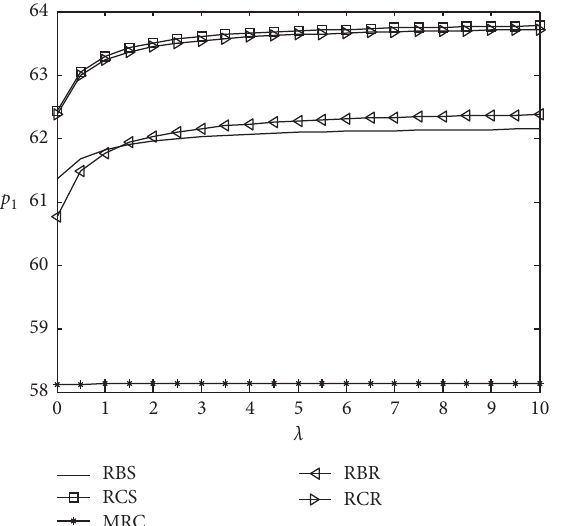
Figure 2: Effect of fairness preference coefficient on retail price.